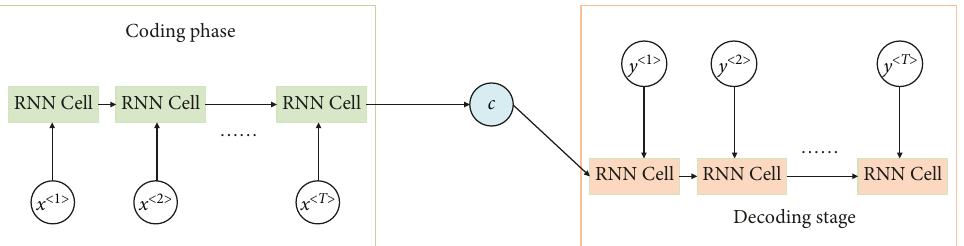
Figure 4: Structure of the encoder-decoder